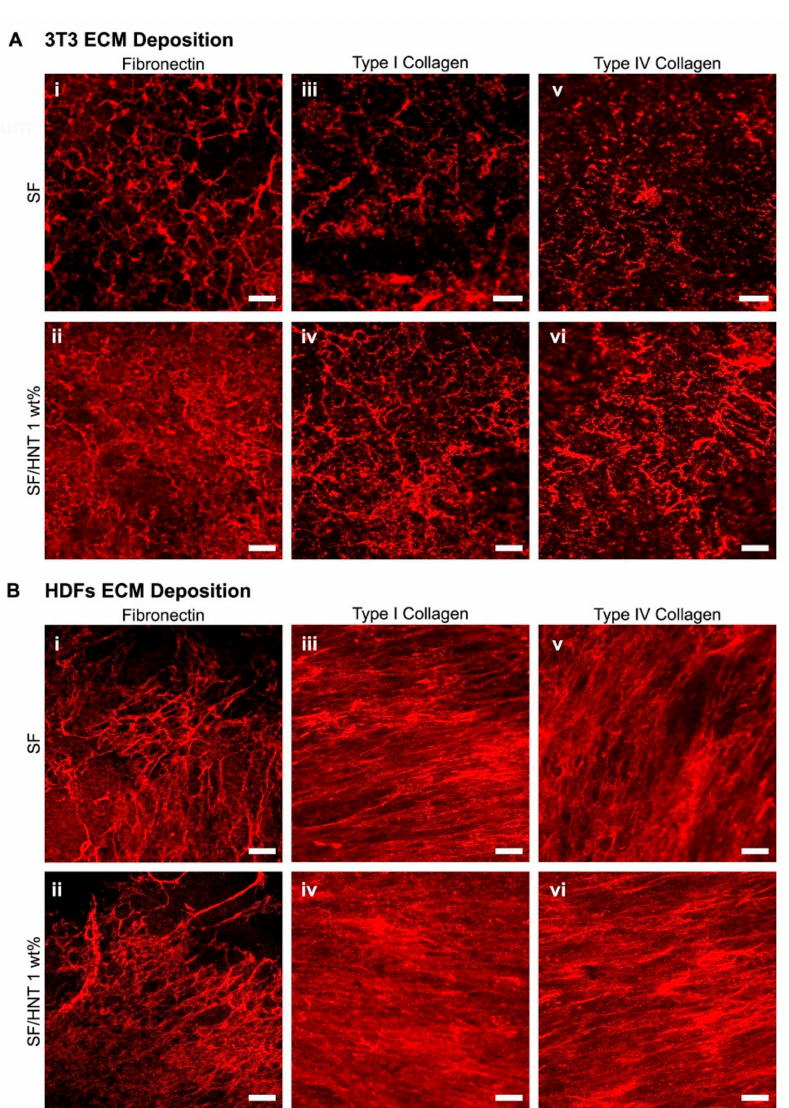
Figure 8. Fibroblasts deposit ECM proteins on the scaffolds. Deposition of fibronectin, collagen I, and collagen IV on SF and SF/HNT 1 wt% composite scaffolds by ( A ) 3T3 fibroblasts: cells (0.25 × 10 4 ) were cultured for 7 days in DMEM (phenol red free) decellularised and the ECM fixed with 4% paraformaldehyde. ( B ) HDFs: HDFs (1 × 10 4 ) were grown in DMEM (phenol red free) until day 7, decellularised and the ECM similarly fixed. Fixed scaffolds were stained with antibodies recognising fibronectin ( i , ii ), collagen I ( iii , iv ), and collagen IV ( v , vi ), with staining visualized using an anti-rabbit Alexa Fluor 647 antibody. Images were captured on a Nikon A1+ confocal microscope; scale bar: 50 µ